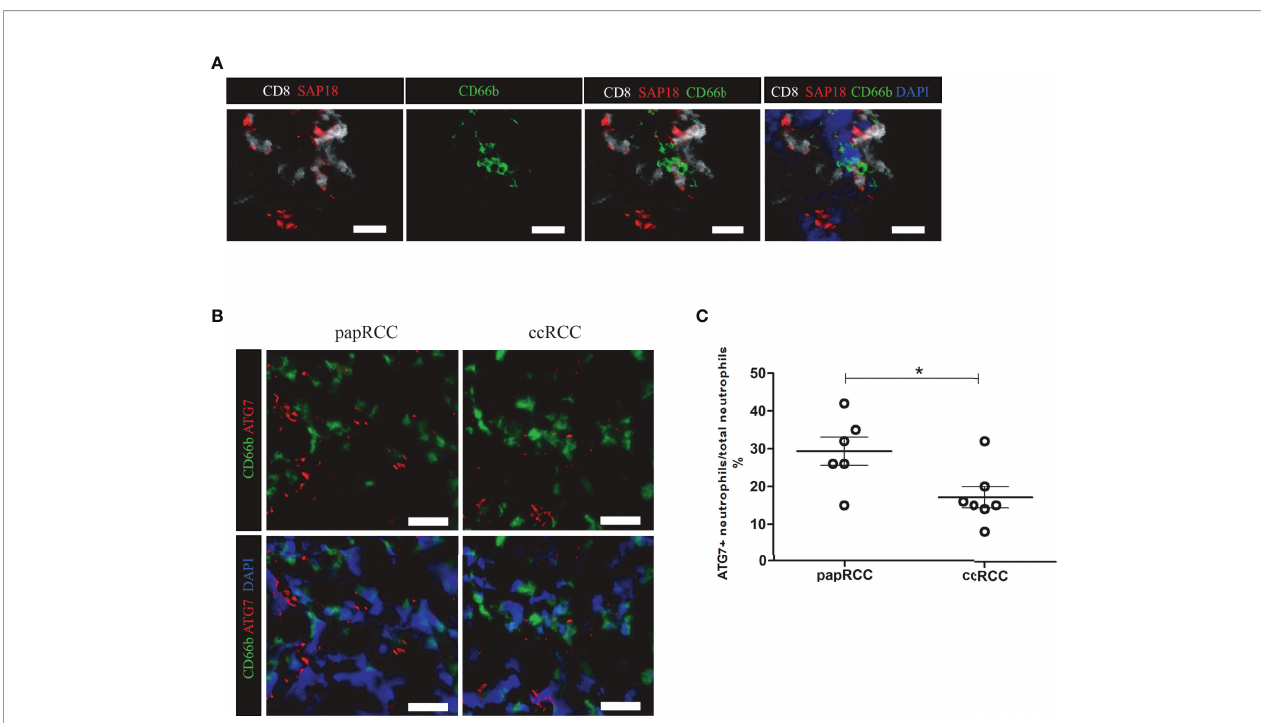
FIGURE 6 | SAP18-expressing CD8+ T cells co-localize with neutrophil in ccRCC biopsies. (A) Immuno fl uorescent imaging showing CD8+ T cells in ccRCC biopsies expressing SAP18, and co-localize with neutrophils. CD8+ T cells showing in white, SAP showing in red, neutrophils were labeled with CD66b (green), cell nucleus were counterstained with DAPI. White scale bar indicates 25 m m. (B) Immuno fl uorescent imaging Neutrophils (CD66b+ cell, green) in ccRCC expressing less ATG7 (red). cell nucleus were counterstained with DAPI. White scale bar indicates 25 m m. (C) Statistical analysis of the frequency of ATG7+ expressing neutrophils against total neutrophils in RCC biopsies. Each dot represented one readout. *: p<0.05. Nonparametric analysis was